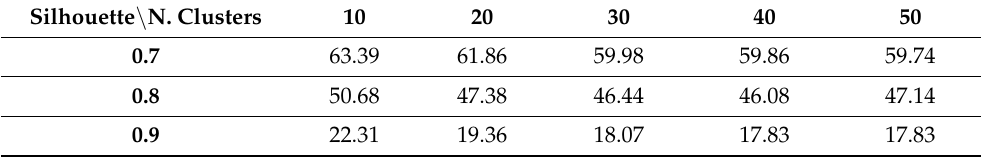
Table 15. Clustering performance in terms of silhouettes using the reduced dataset with SPQR. Silhouette \ N.